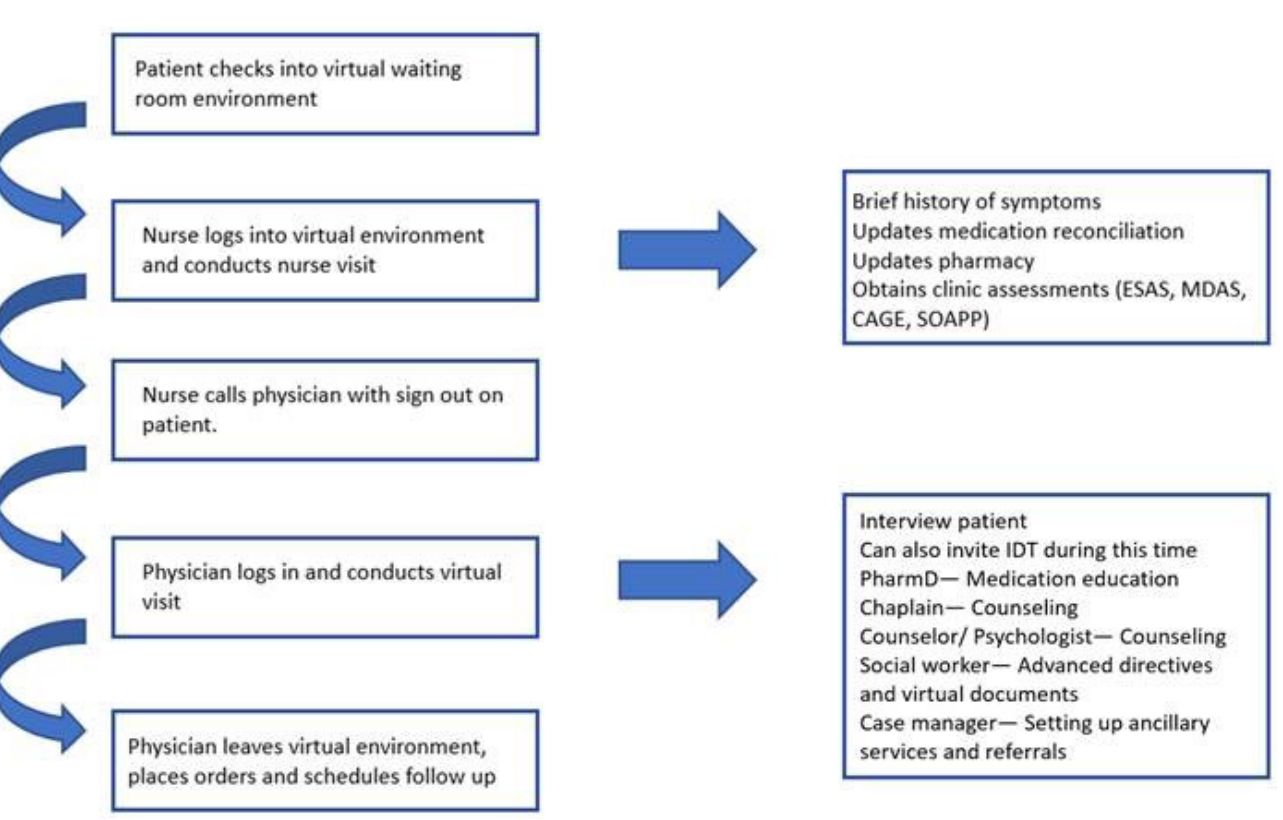
Figure 1. Virtual visit workflow in a supportive care clinic. Abbreviations: ESAS: Edmonton Symptom Assessment System; MDAS: Memorial Delirium Assessment Scale; CAGE: Cut-Down, Annoyed, Guilty and Eye-Opener Questionnaire; SOAPP: The Screener and Opioid Assessment for Patients with Pain; IDT: interdisciplinary team.